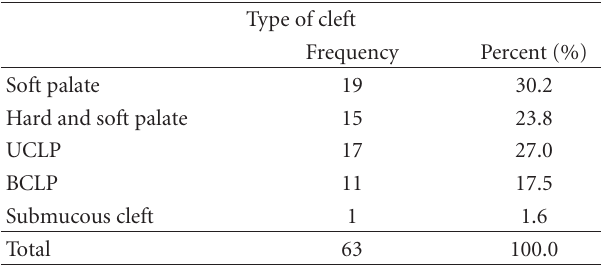
Table 5: Distribution of cleft types in the intervention group. UCLP: unilateral cleft lip and palate; BCLP: bilateral cleft lip and palate.